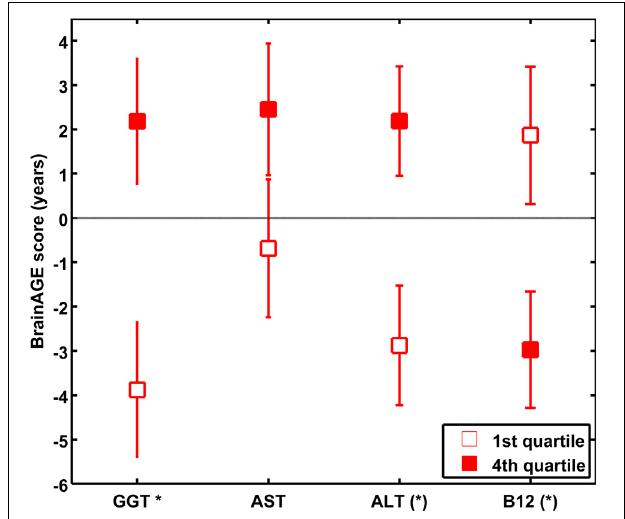
FIGURE 6 | The effects of extremely low vs. extremely high levels in clinical markers on BrainAGE in the female sample. Mean BrainAGE scores of female subjects in the 1st (plain) and the 4th quartiles (filled squares) of the most significant physiological and clinical chemistry parameters (i.e., GGT, AST, ALT, and vitamin B 12 ). Error bars depict the standard error of the mean (SEM). [( ∗ ) p < 0 . 05 before Bonferroni-Holm correction; ∗ p < 0 . 05 after Bonferroni-Holm